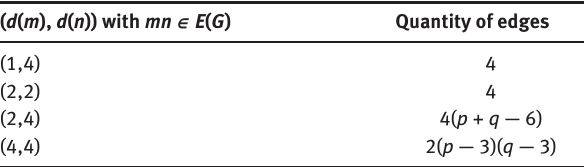
Table 1: The cardinality of edges of type ( d ( m ), d ( n )) of L where m and n are degrees of adjacent vertices of every